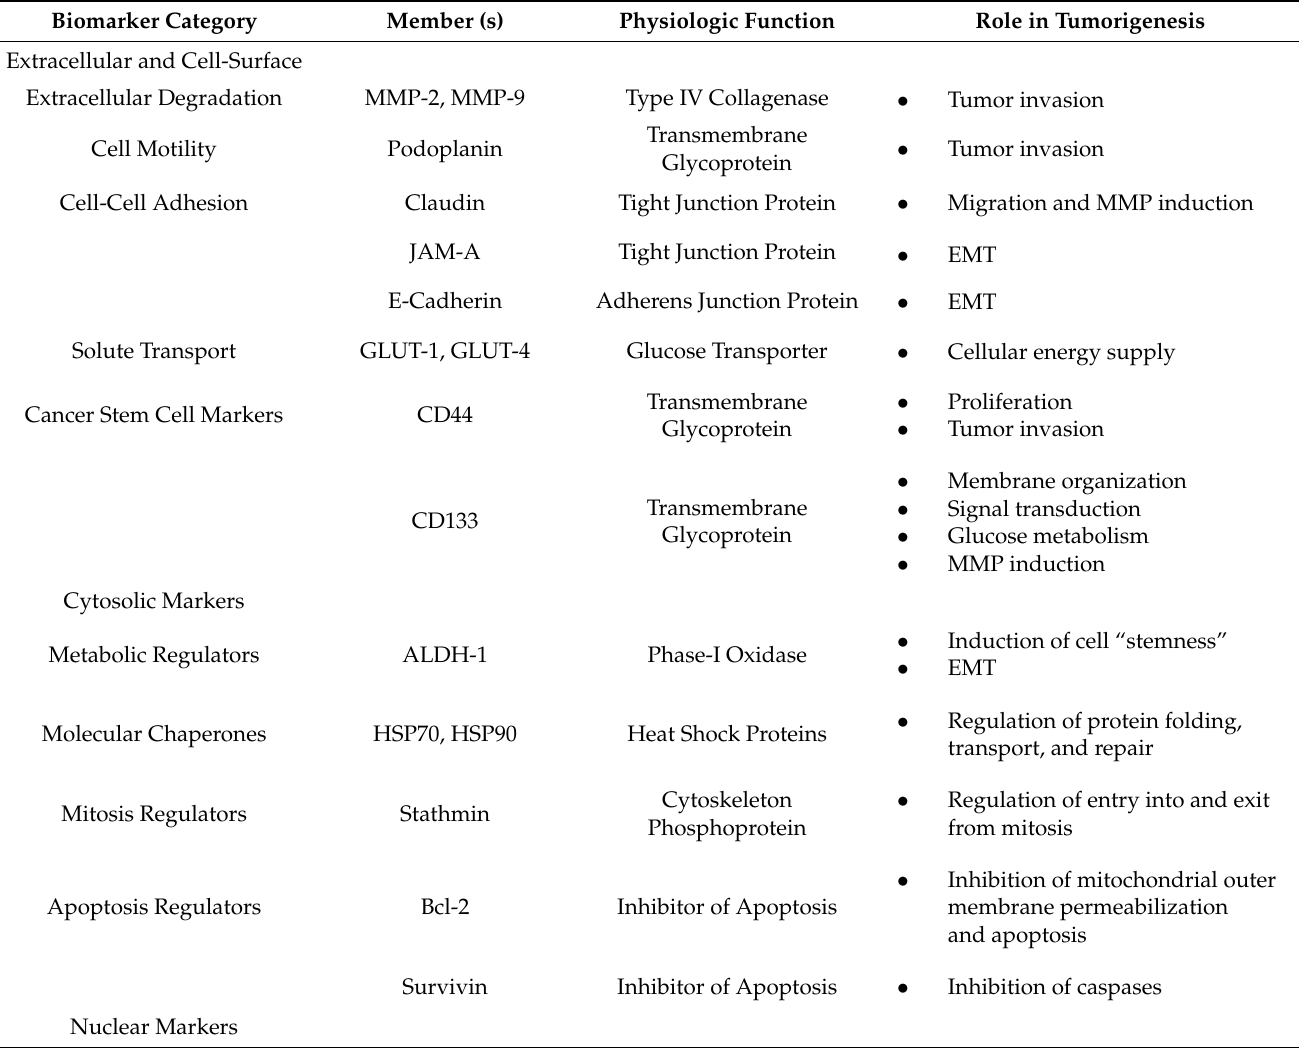
Table 1. Histopathologic markers of malignant transformation in head and neck